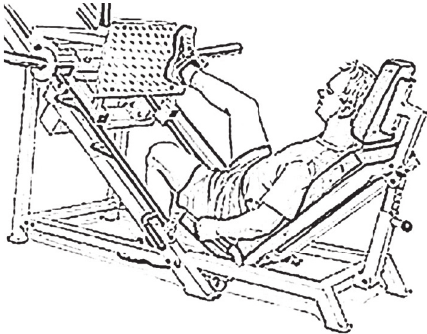
Figure 1: A sketch representation of the unilateral exercise type targeting the hip extensor muscles investigated in the present